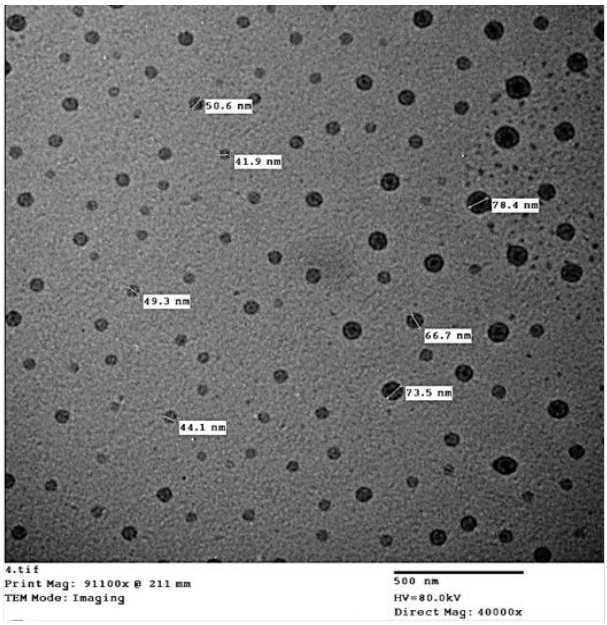
Figure 3. Nitrogen nanoparticles.